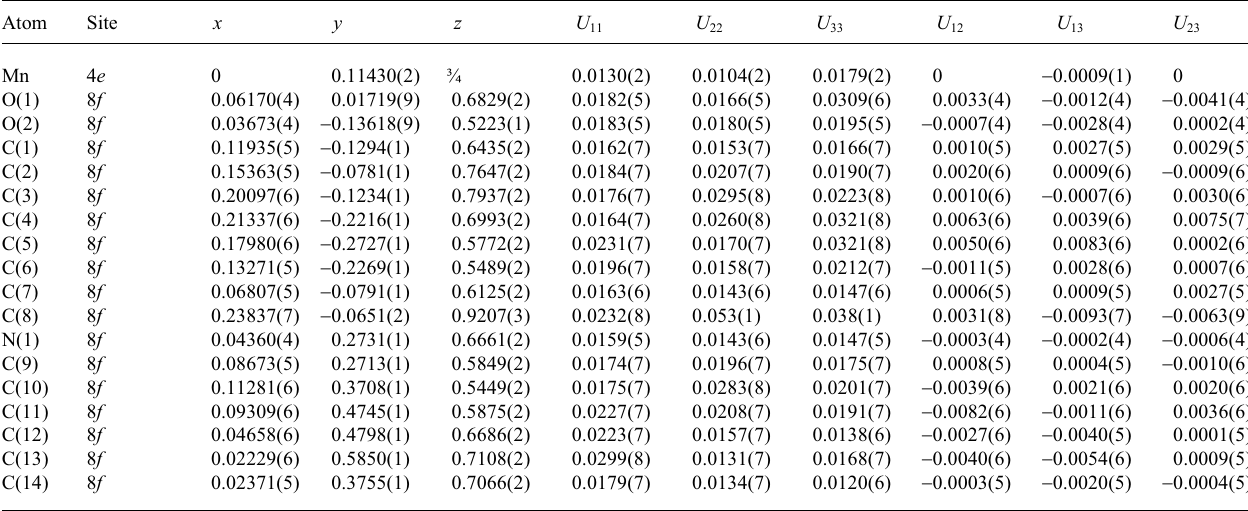
Table 3. Atomic coordinates and displacement parameters (in Å 2 )